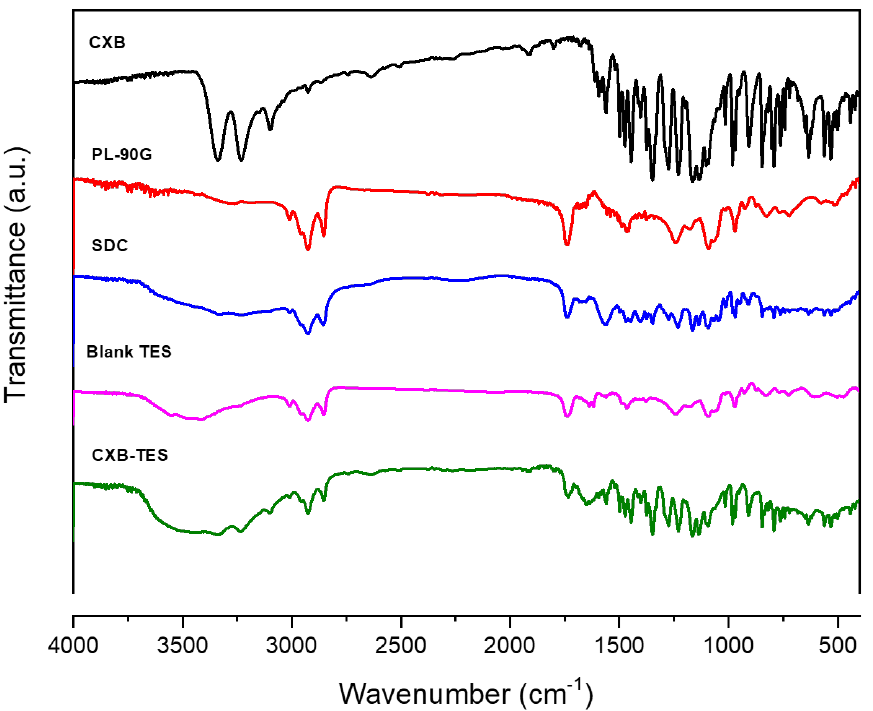
Figure 2. FT-IR spectra of CXB, phospholipone (PL-90G), sodium deoxycholate (SDC), blank TES, and the selected CXB-TES (F4).